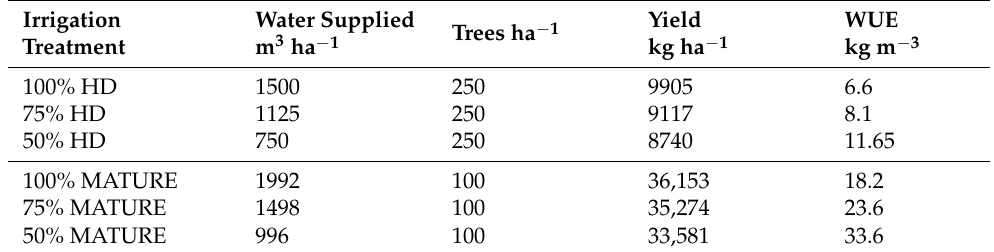
Table 11. Water supplied per hectare, number of trees, yield and WUE for mature and HD trees. Irrigation Water Treatment